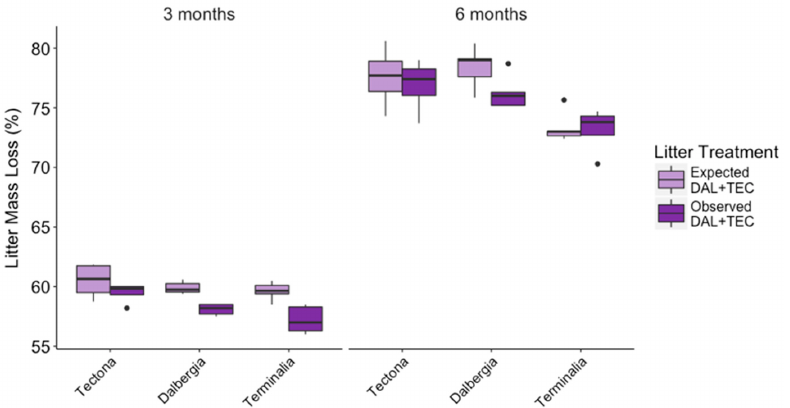
Figure 7. Non-additive effects of mixed litter from Tectona grandis (TEC) and Dalbergia retusa (DAL), showing the expected mass loss, calculated as the mean mass loss of the single-species litters, and the observed mass loss after three and six months of decomposition in monoculture plantations of Tectona grandis, Dalbergia retusa and Terminalia amazonia as part of a litter decomposition experiment in Panama, Central America. Boxes show the interquartile range (IQR) with median lines for n = 5, and dots show outliers.